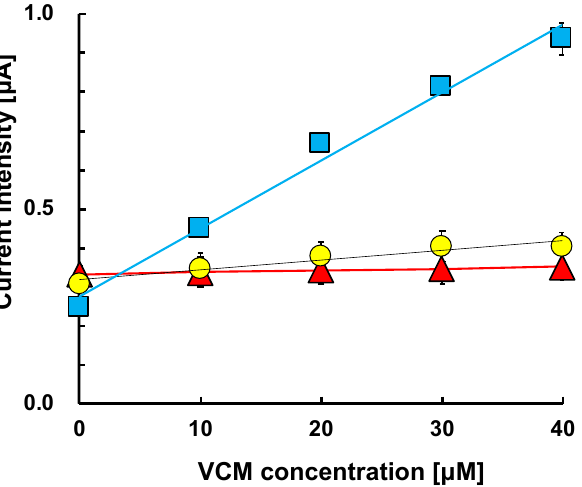
Figure 7. Relationship between VCM concentration and current intensity at MIP-ITO electrodes us- ing both ACPF and MAA (squares), using ACPF only (circles), and using MAA only (triangles) during the graft-copolymerization process.